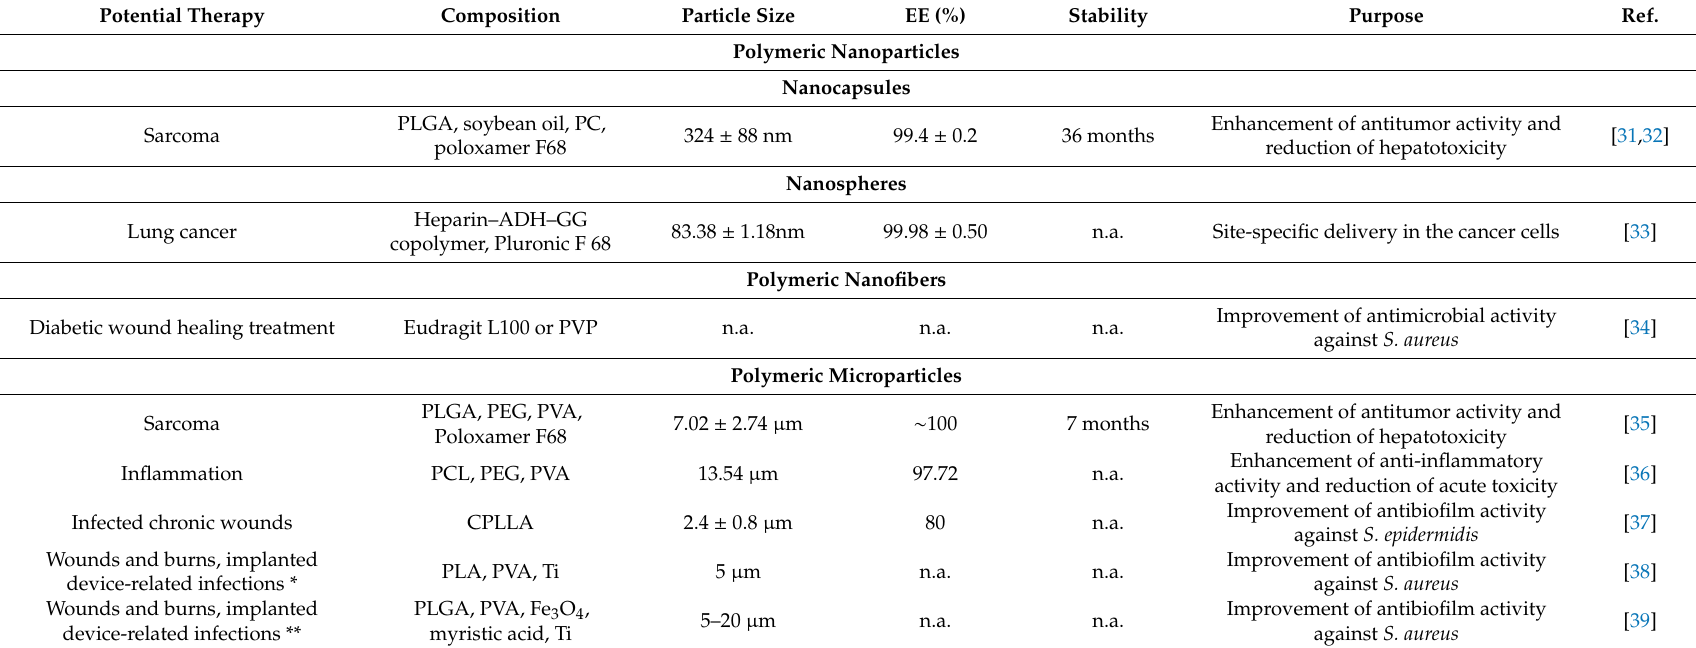
Table 3. List of the investigated usnic acid-loaded polymeric nano- and